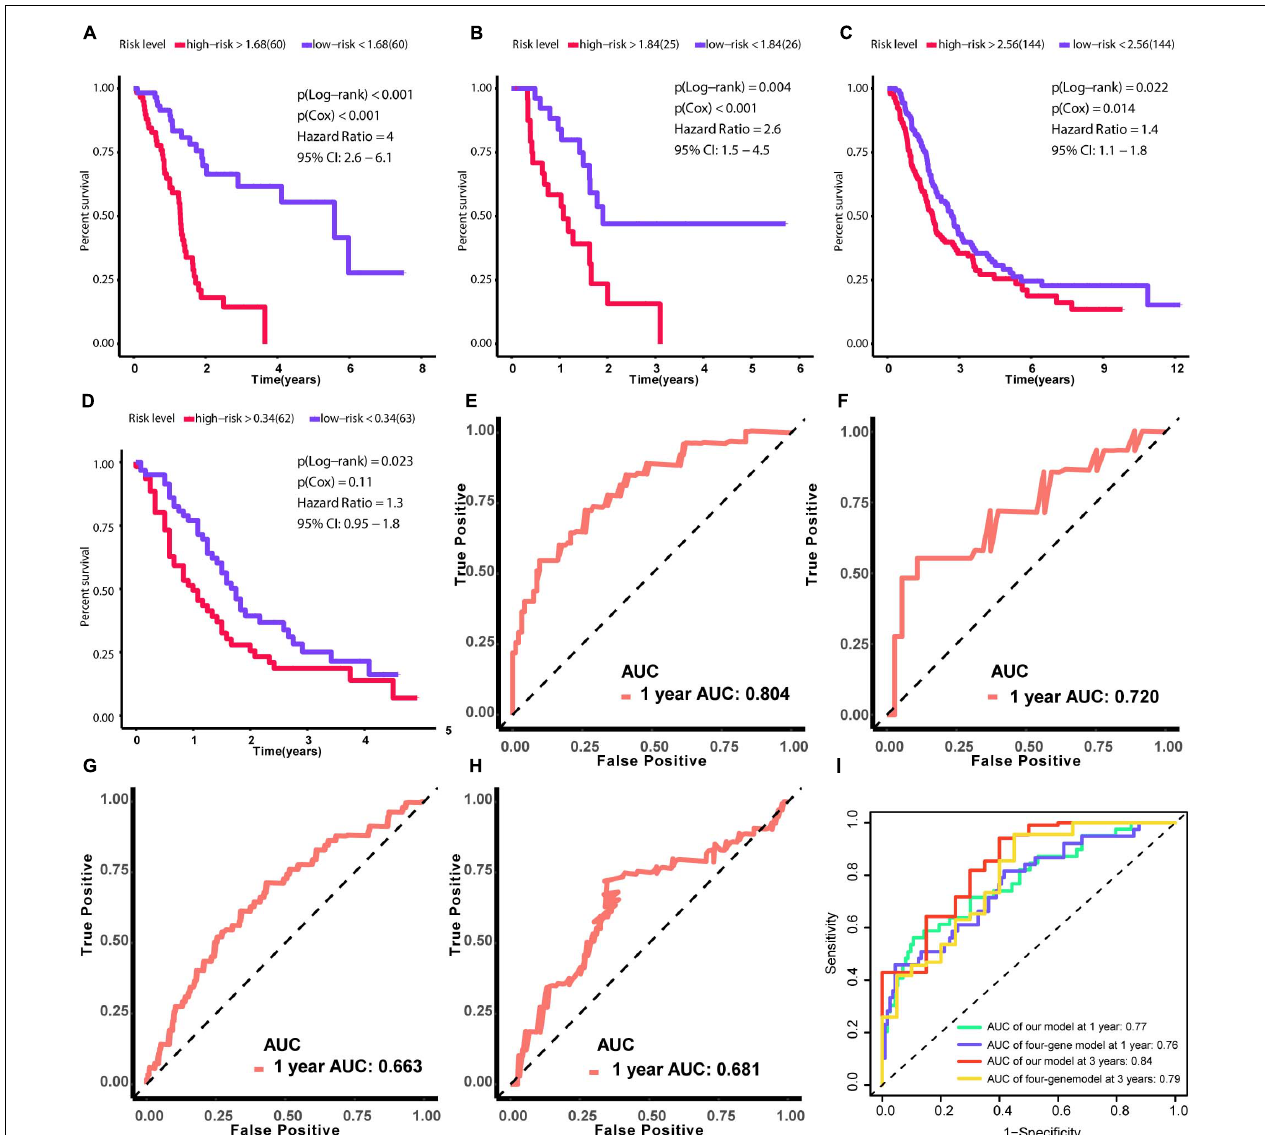
FIGURE 8 | Verification of the effectiveness of the prognostic signature. (A–D) Survival analysis based on Kaplan–Meier curves. (E–H) ROC curve for 1-year follow-up. (A,E) Results obtained using the training set. (B,F) Results obtained using the internal validation set. (C,G) Results obtained using GSE729. (D,H) Results obtained using E-MTAB-6134. (I) The comparison between our model and the existed four-gene model in term of tdROC curves. (AUC, area under curve; tdROC, time-dependent receiver operating characteristic). The clinical outcome endpoint was overall survival. P < 0.05 was defined as statistically significant.